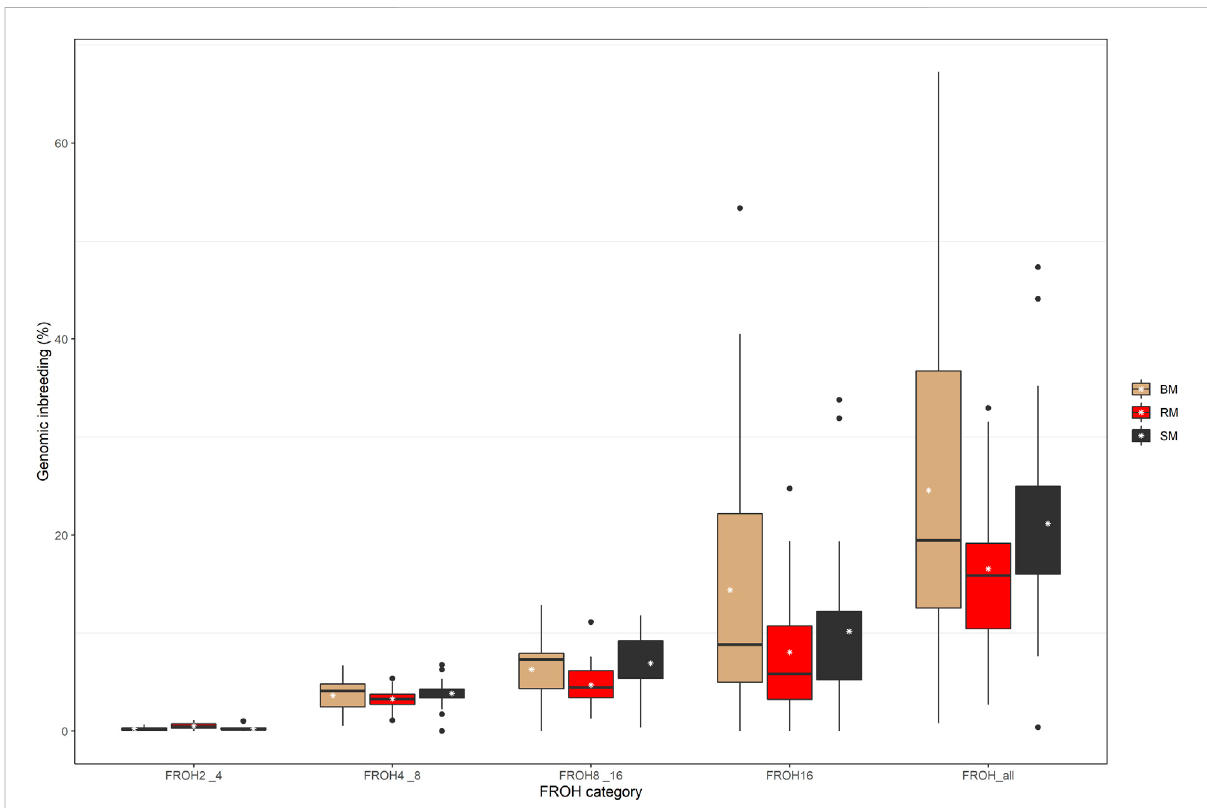
FIGURE 6 Boxplot showing the distribution of genomic inbreeding for various ROH length categories in Blond, Red and Swallow-bellied Mangalitsa pigs. The white stars represent estimate of average inbreeding.